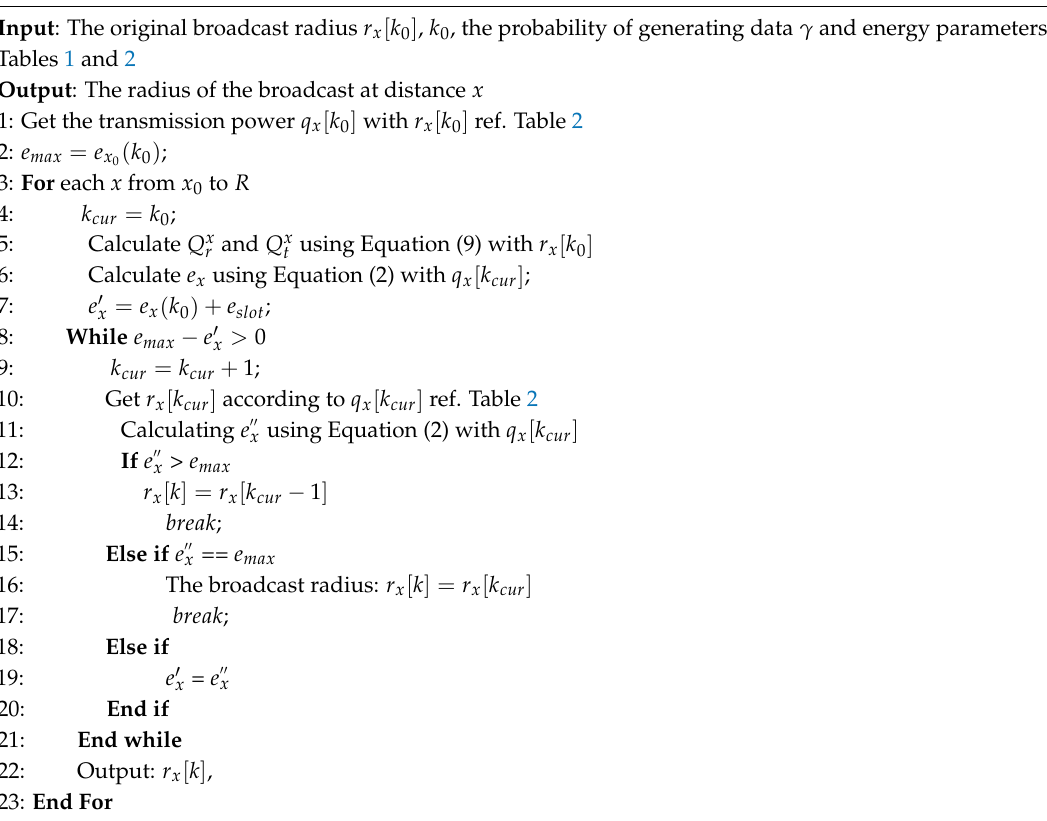
Algorithm 1. Calculate the Broadcast Radius at a Different Distance from the Sink Tables 1 and